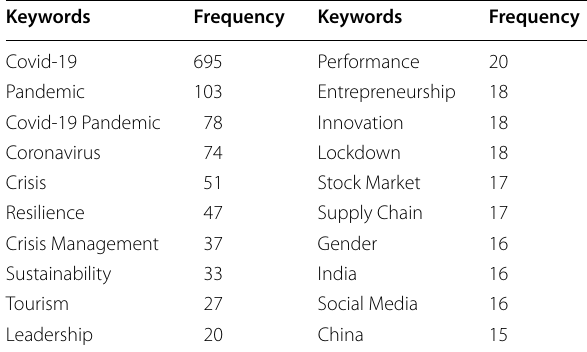
Table 6 Most frequently used keywords in the topic Covid‑19 and